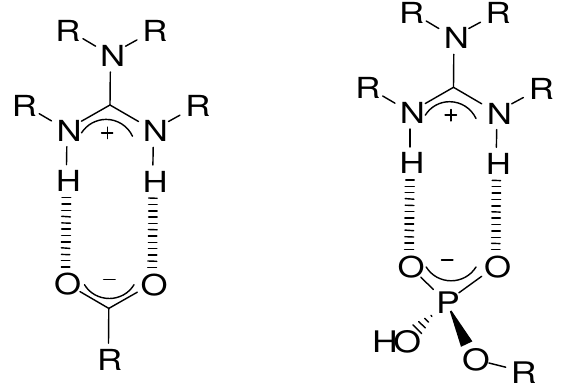
Figure 3. Binding pattern of the guanidine moiety toward carboxylic and phosphate anions deduced from a guanidine-nitrate complex X-ray